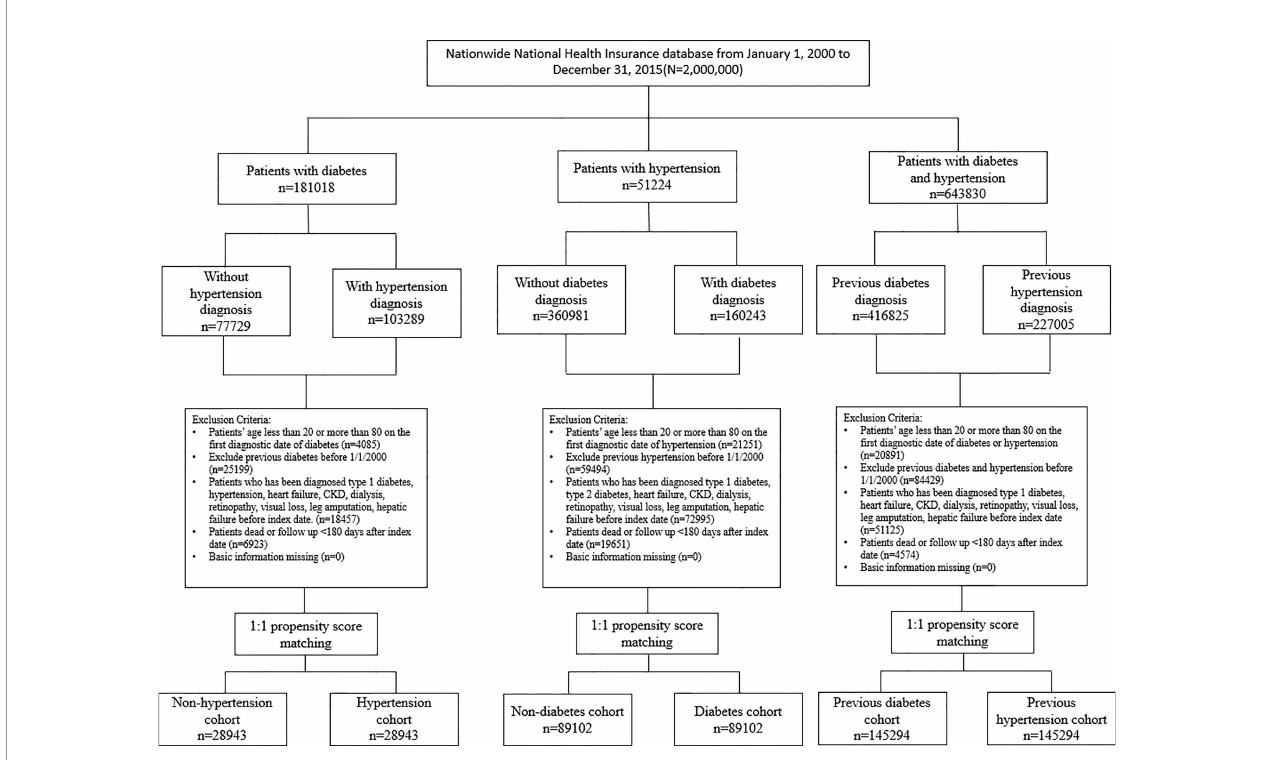
FIGURE 1 | Flow chart of the identi fi ed study